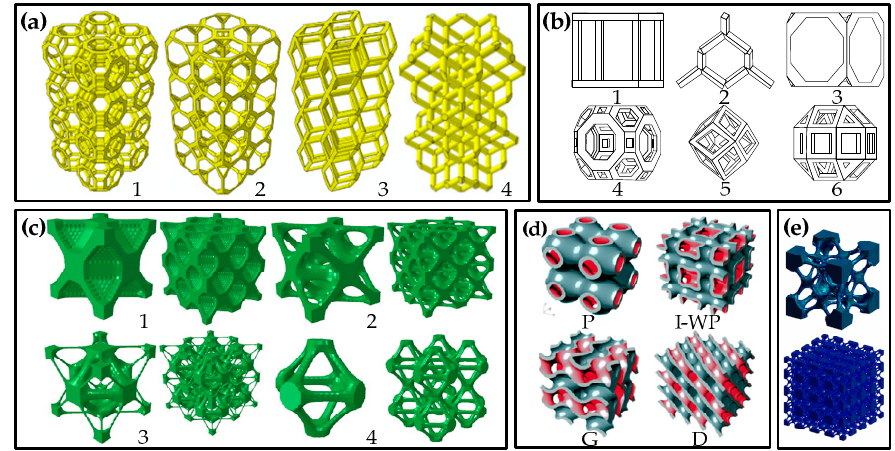
Figure 7. Common lattice structure design: ( a ) Polyhedral model (circular), reproduced from [95], with copyright permission from Elsevier, 2018, from left to right: Truncated cuboctahedron, Truncated cube, Rhombic dodecahedron, and Diamond; ( b ) polyhedral model (square), reproduced from [7], with copyright permission from authors, 2015, according to the serial number: Cubic, Diamond, Truncated cube, Truncated cuboctahedron, Rhombic dodecahedron, and Rhombicuboctahedron; ( c ) topology configuration based on BESO, reproduced from [120], with copyright permission from Elsevier, 2011, the topological unit cell and the overall structure obtained according to the volume fraction is 40%, 30%, 20%, 10% in order; ( d ) common four triply periodic minimal surfaces (TPMS) structures, reproduced from [8], with copyright permission from Elsevier, 2017, Prime, I-WP, Gyroid, and Diamond in order; ( e ). Three-dimensional porous structure based on the multi-phase topology optimization (MPTO) method reproduced from [121], with copyright permission from AIP Publishing, 2008, unit cell and overall structure.